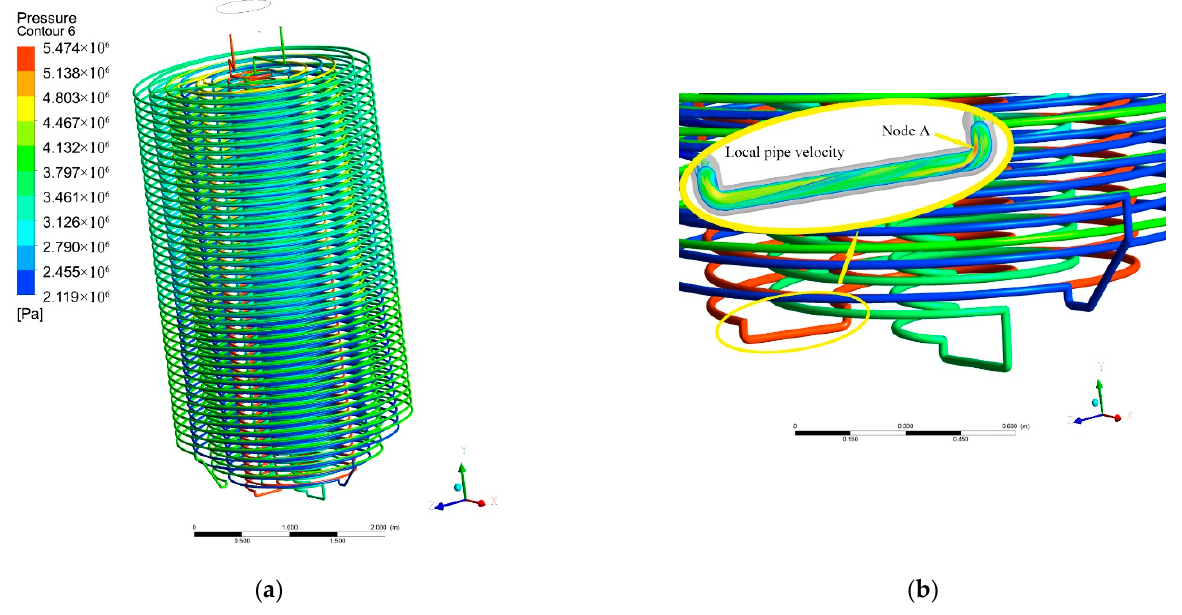
Figure 16. 3D stress nephogram of coil. ( a ) Coil’s stress nephogram; ( b ) Local flow diagram of coil.